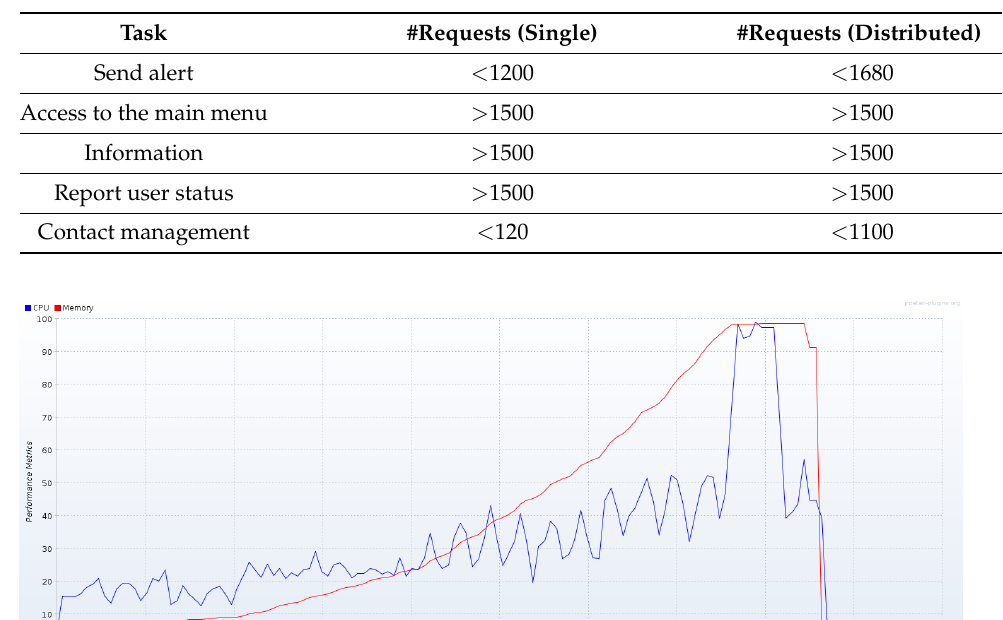
Table 3. Number of requests supported by each task of Jayma on a single processor and in a distributed manner with two processors.